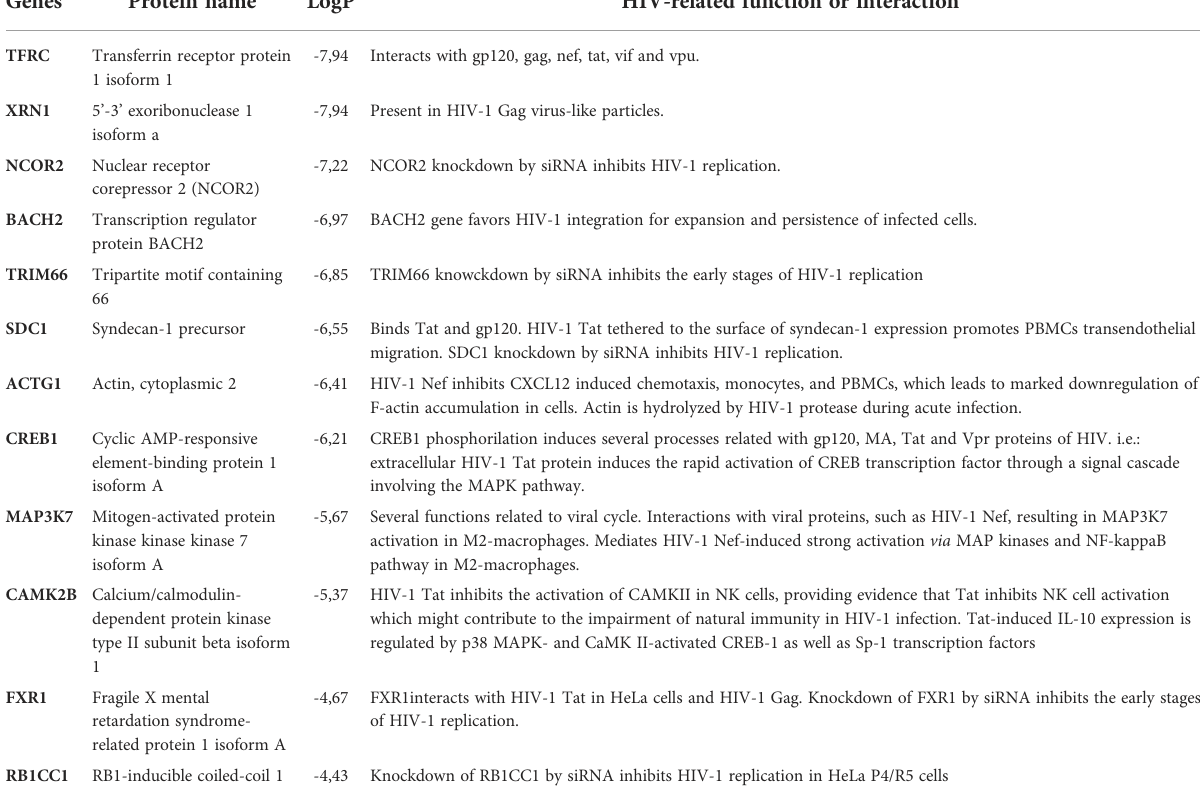
TABLE 2 Selection of most relevant miR-10a-5p targets involved in relevant host-HIV interactions. Genes Protein